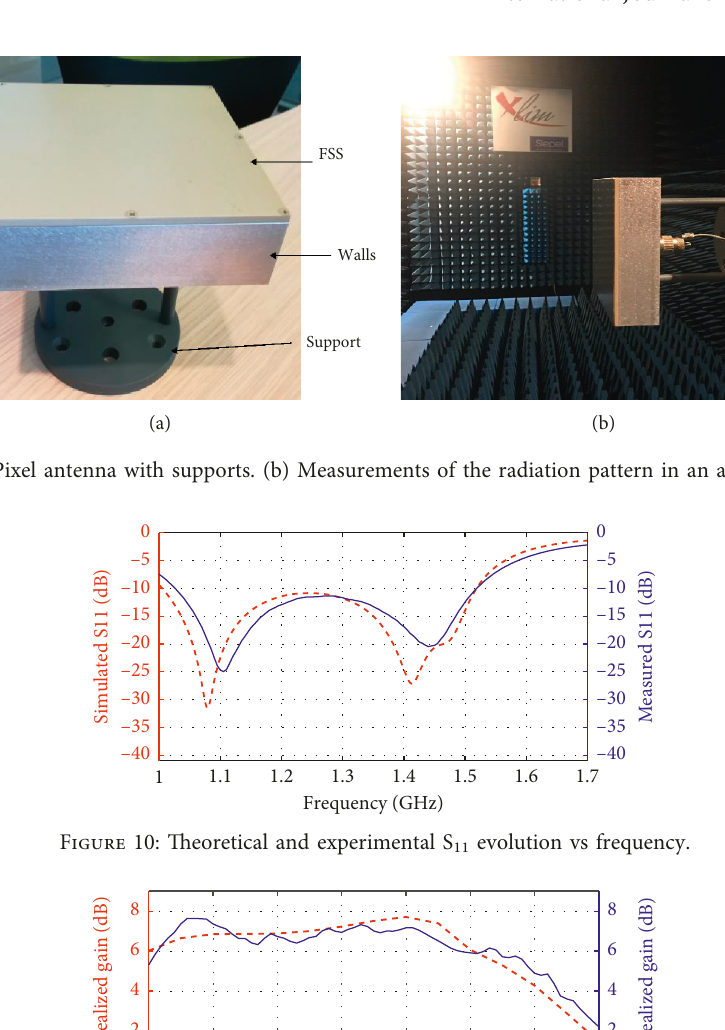
Figure 11: Theoretical and experimental maximum realized gains evolution vs function of the frequency.